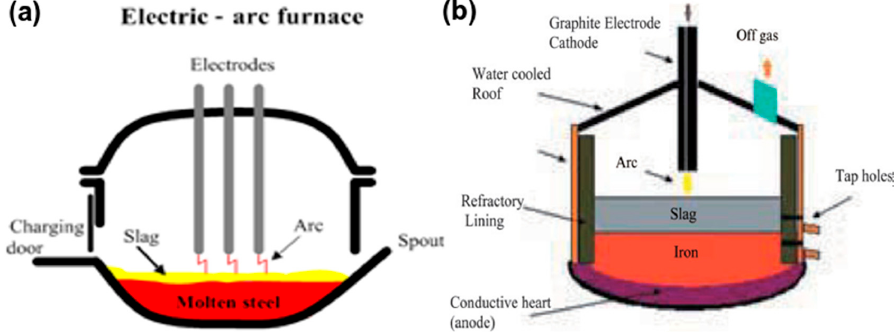
Figure 12. Schemes of ( a ) AC and ( b ) DC electric arc furnaces (EAFs). Reprinted from [46] with permission from Taylor & Francis 2010. permission from Taylor & Francis